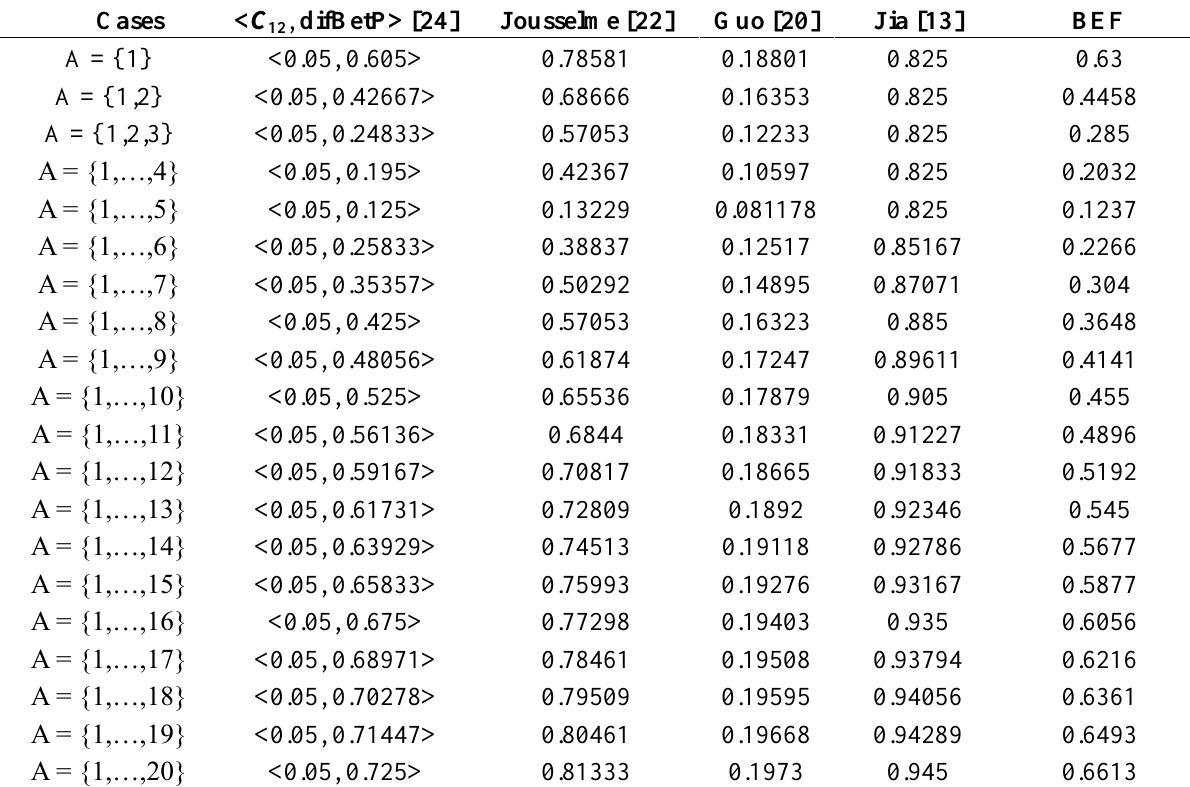
Table 5. Comparisons of different conflict measurement methods.